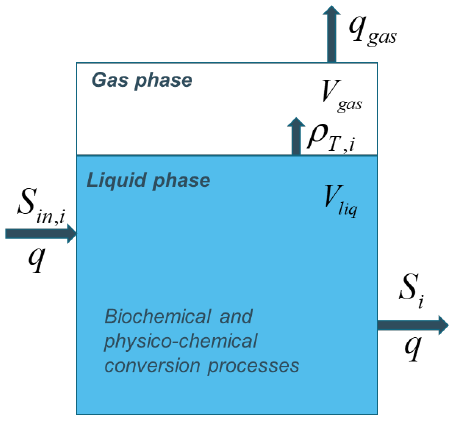
Figure 5. Anaerobic digestion